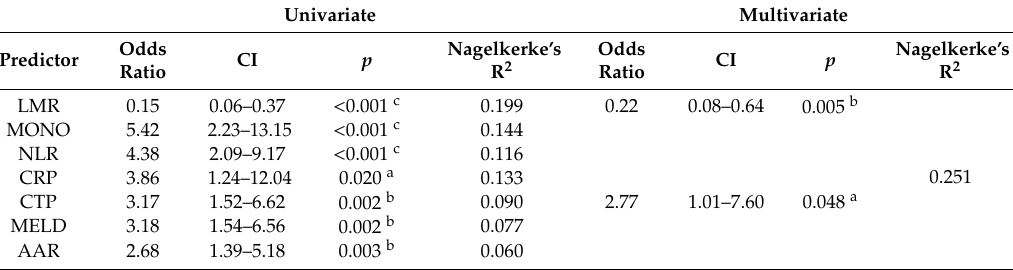
Table 5. Odds ratio for selected